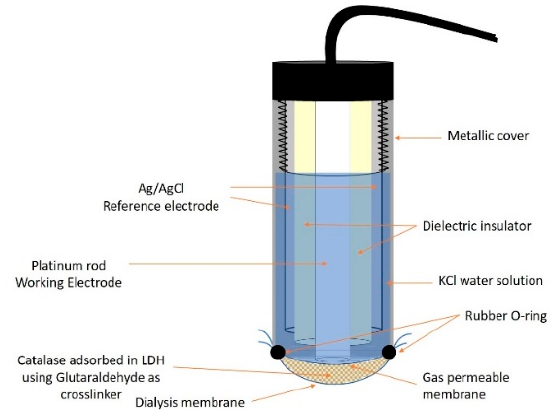
Figure 2. Clark-LDH-catalase enzyme biosensor.